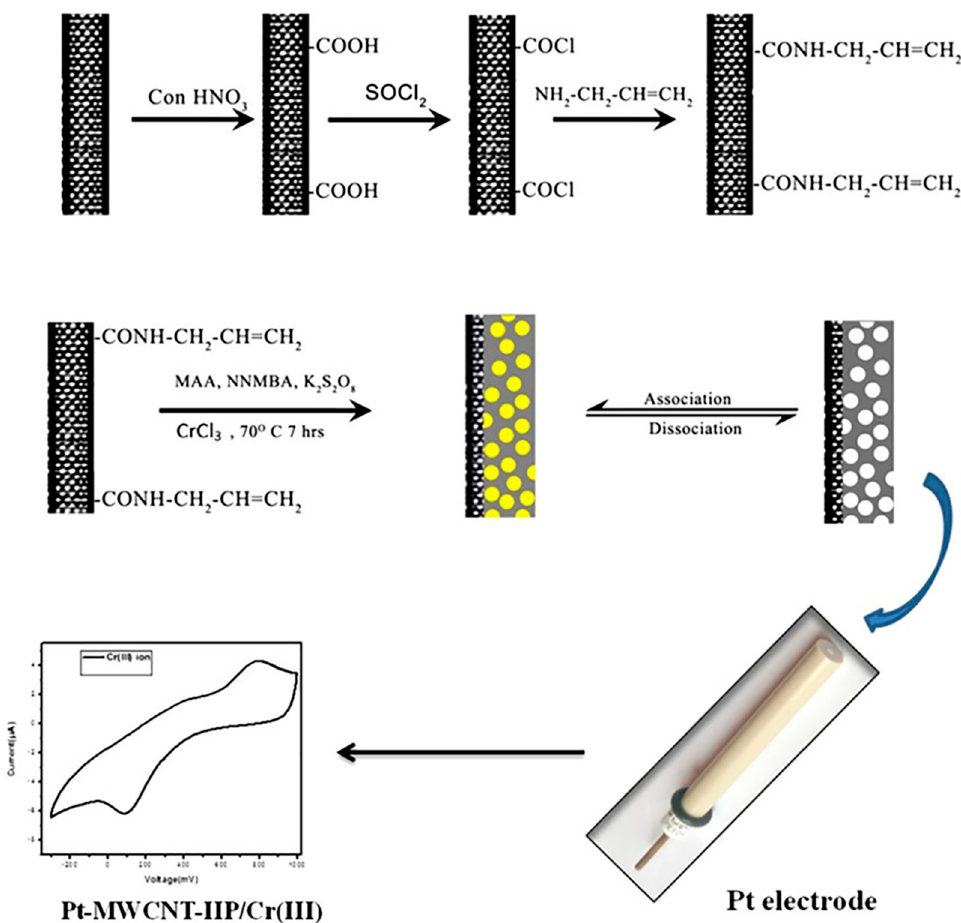
Figure 5. The preparation of Pt-MWCNT-IIP electrode. Reprinted with permission from Ref. [89]. Copyright 2018, John Wiley and Sons.